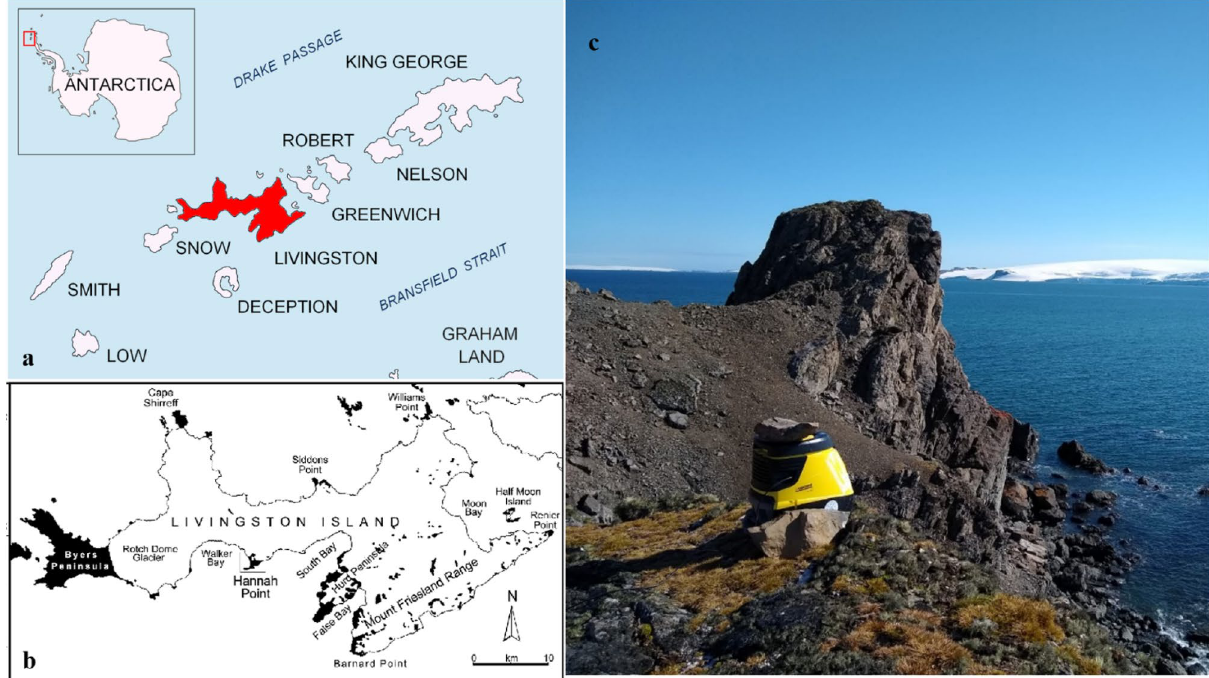
Figure 1. Location of soil sample collections. ( a ) Antarctic Peninsula, ( b ) Livingston Island and ( c ) Punta Polaca at Hurd Peninsula, where the air and snow were sampled [62°40 ′ 16 ″ S; 60°22 ′ 43 ″ W]. Photo ( c ) by T